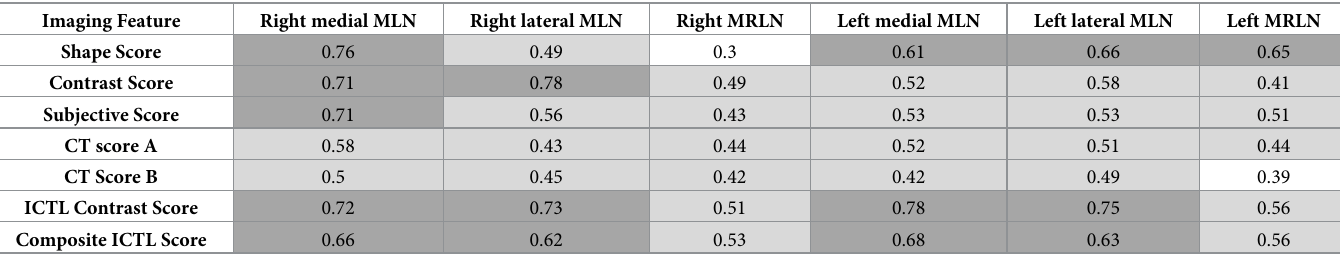
Kappa agreement was color coded for poor (white), moderate (light grey), and substantial (dark grey). This was done for the mandibular lymph nodes (MLN) and medial retropharyngeal lymph nodes (MRLN).